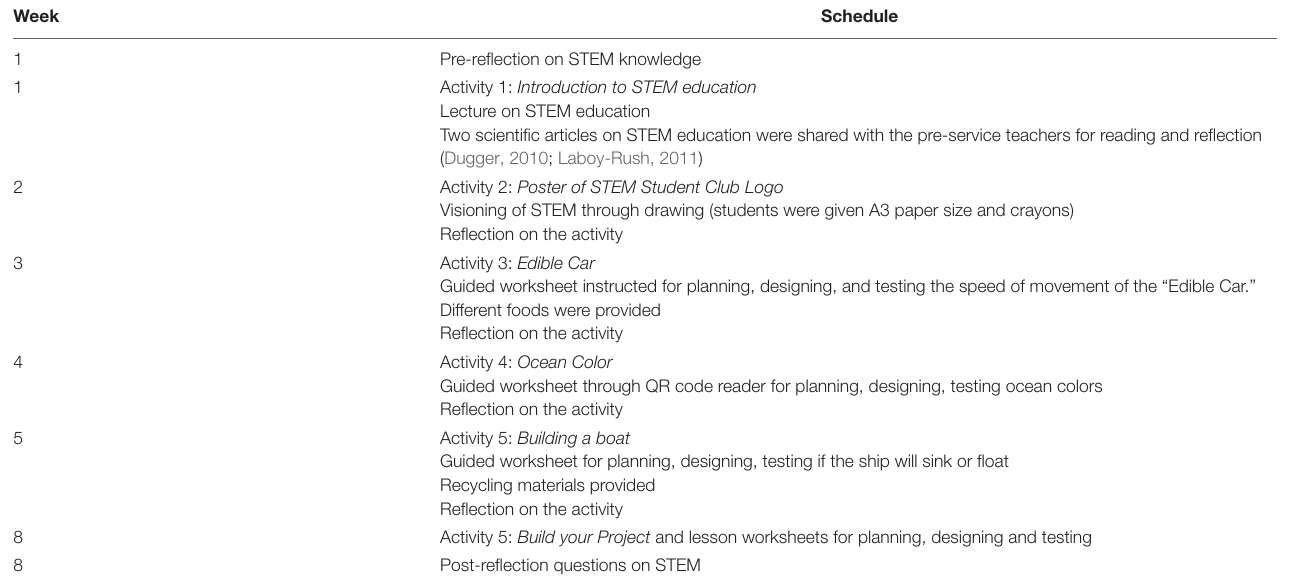
TABLE 1 | The activities for the STEM professional development workshop (Akaygun and Aslan-Tutak, 2020). Week Schedule Pre-reflection on STEM knowledge Activity 1: Introduction to STEM education Lecture on STEM